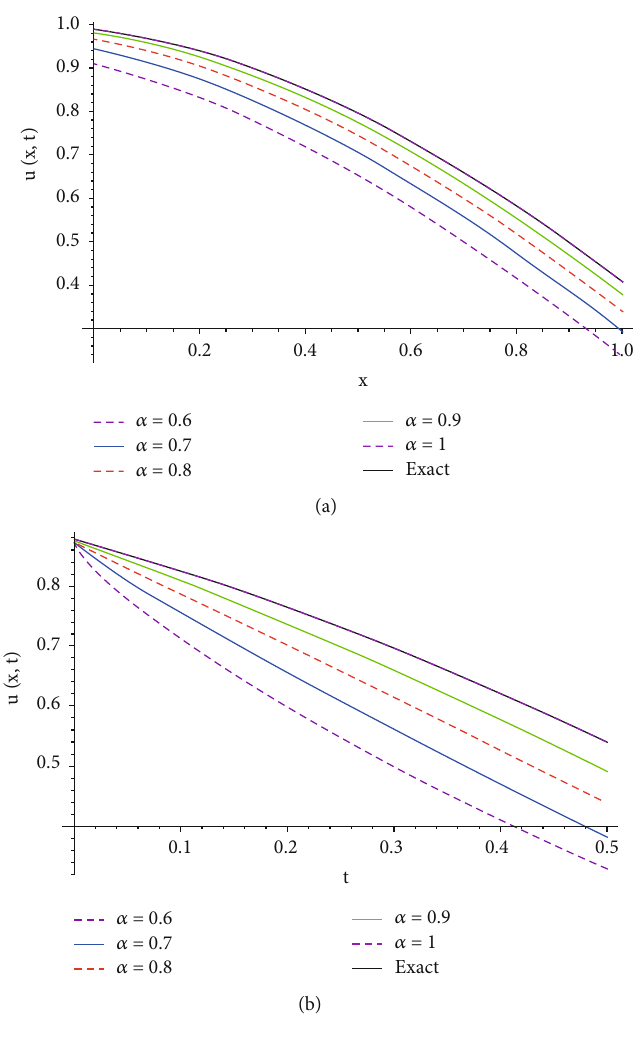
Figure 2: FRDTM solution pro fi le of Eq. (21): (a) u ð x , t Þ vs. x for di ff erent values α and t = 0 : 15 and (b) u ð x , t Þ vs. time t for di ff erent values α and x = 0 : 5